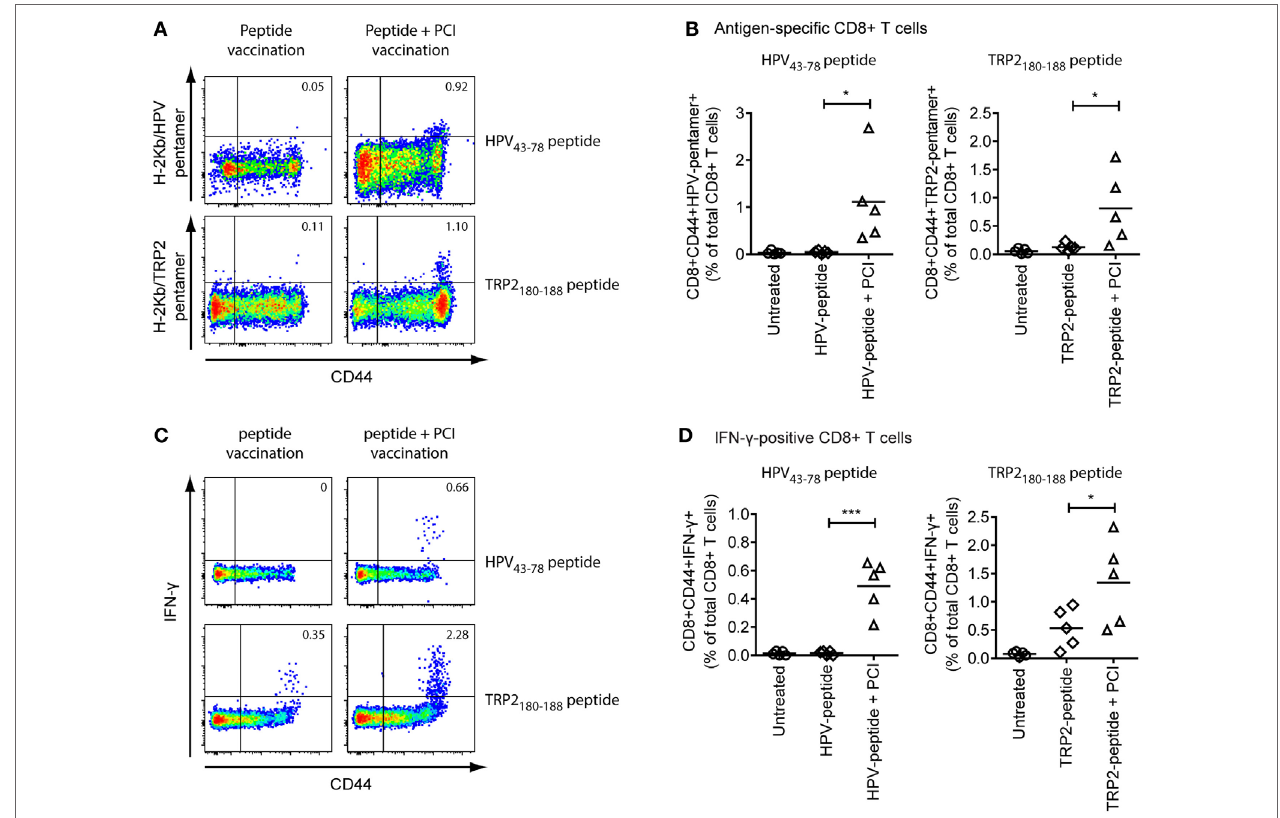
FigUre 5 | Intradermal vaccination of C57BL/6 wild-type mice with peptide antigens and photochemical internalization (PCI) effectively induces antigen-specific CD8 + effector T cell responses. Groups of five C57BL/6 wild-type mice were intradermally immunized with TRP-2 180–188 or HPV 43–78 peptide ± PCI treatment. Mice received three identical vaccination treatments with 14-day intervals. (a) 10 days after the last vaccination, frequencies of activated, antigen-specific CD8 + CTLs were analyses from blood samples with HPV 49–57 or TRP-2 180–188 peptide-loaded MHC class I pentamers (CD8 + CD44 + pentamer + cells). Plots show representative examples of flow cytometric analysis for HPV 43–78 (upper panels) or TRP-2 180–188 (lower panels) vaccinated mice without (left) or with PCI treatment (right). (B) Quantification of activated HPV 43–48 -specific (CD8 + CD44 + H-2Kb/HPV 49–57 -pentamer + cells, left) and TRP-2 180–188 -specific (CD8 + CD44 + H-2Kb/TRP-2 180–188 - pentamer + cells, right) activated CD8 + T cells from all five mice in each group of the experiment. (c) Frequencies of interferon (IFN)- γ effector cytokine producing CD8 + CTLs were analyzed from spleen cells after overnight stimulation with TRP-2 180–188 or HPV 43–78 peptide, respectively (CD8 + CD44 + IFN- γ+ cells). Plots show representative examples of flow cytometric analysis for HPV 43–78 (upper panels) or TRP-2 180–188 (lower panels) vaccinated mice without (left) or with PCI treatment (right). (D) Quantification of IFN- γ effector cytokine production from CD8 + T cells (CD8 + CD44 + IFN- γ+ T cells) from HPV 43–48 -vaccinated (left) and TRP-2 180–188 - vaccinated mice for all five mice in each group of the experiments. Horizontal lines in scatter graphs indicate median values; P values were calculated using an unpaired two-tailed t -test to compare pairs of datasets (* P < 0.05). Vaccination experiments were performed twice and with similar